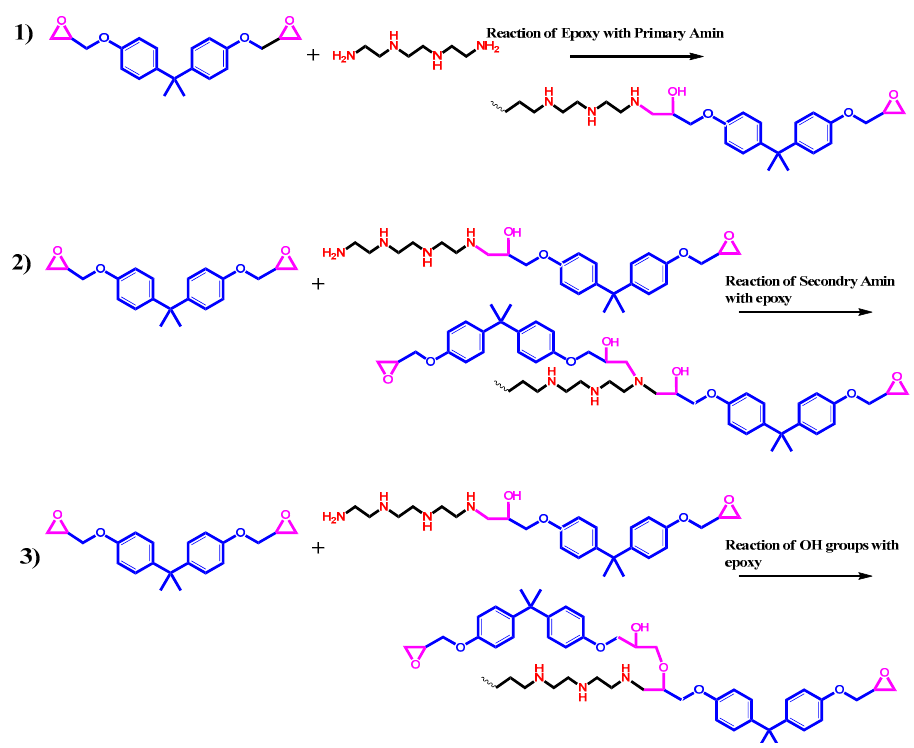
J. Compos. Sci. 2020 , 4 , x FOR PEER REVIEW Figure 3. The typical reaction of epoxy with an amine-based curing agent. Figure 3. The typical reaction of epoxy with an amine-based curing agent.